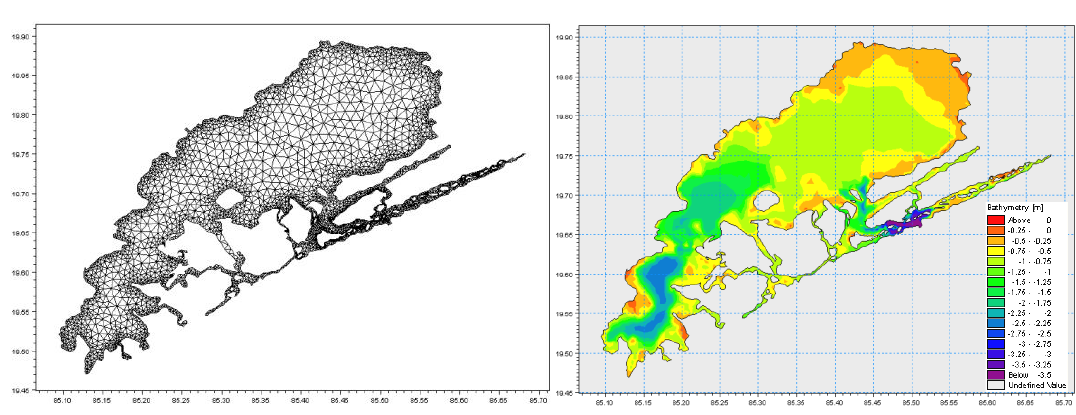
Figure 2. The Flexible mesh structure of Chilika Lagoon